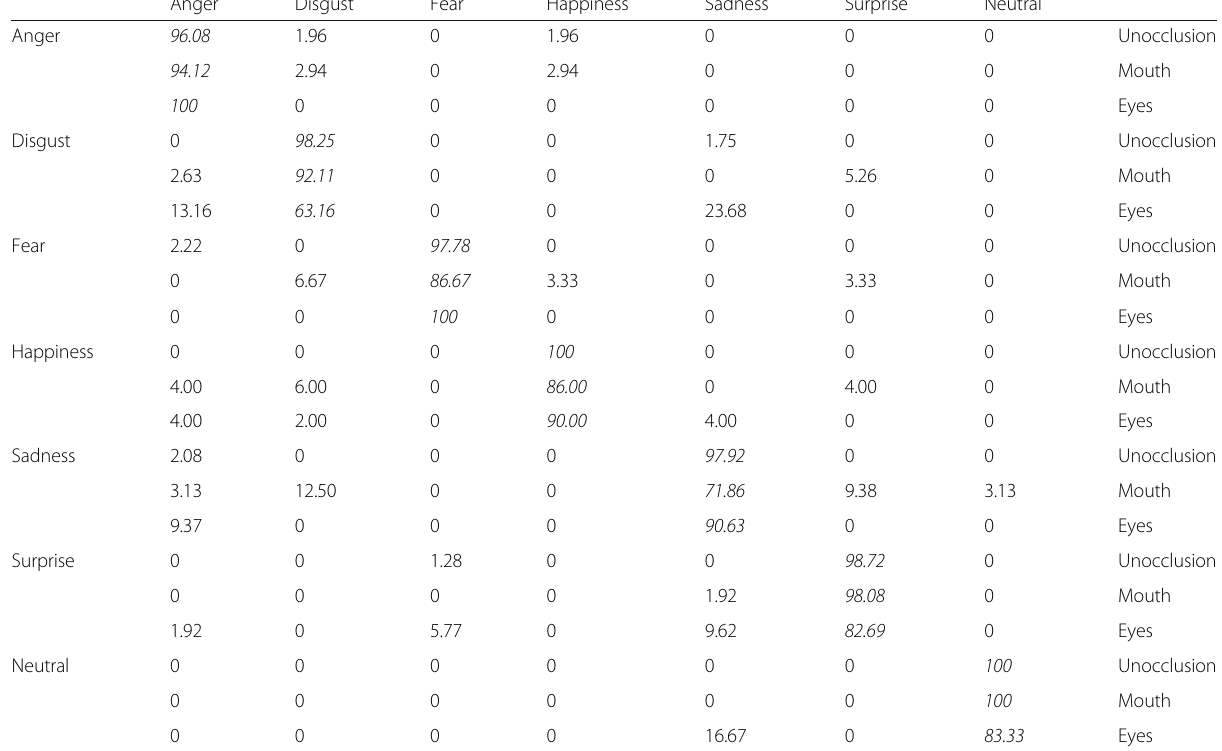
Table 8 Confusion matrix of 7-class facial expression recognition using proCMF on CK+ dataset with unocclusion and eyes and mouth occlusions (%) Anger